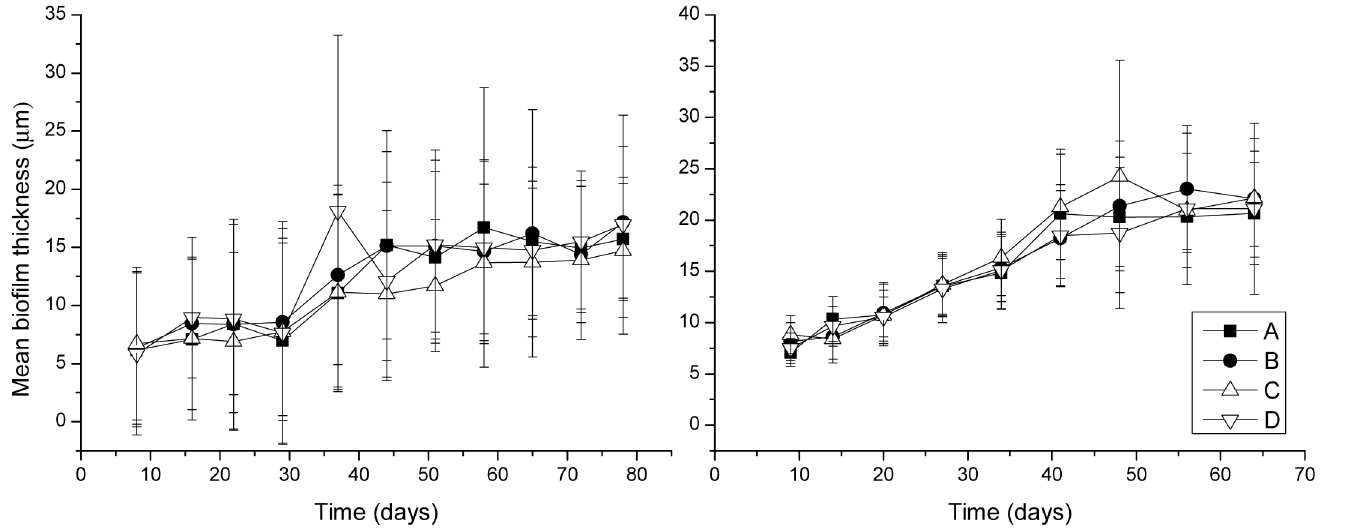
Fig 1. Mean biofilm thickness measured using light microscopy as a function of time in bioreactors A, B, C, and D for experiment with flushed Golden State water (left) and flushed Bethlehem water (right), respectively. Error bars indicate one standard deviation.